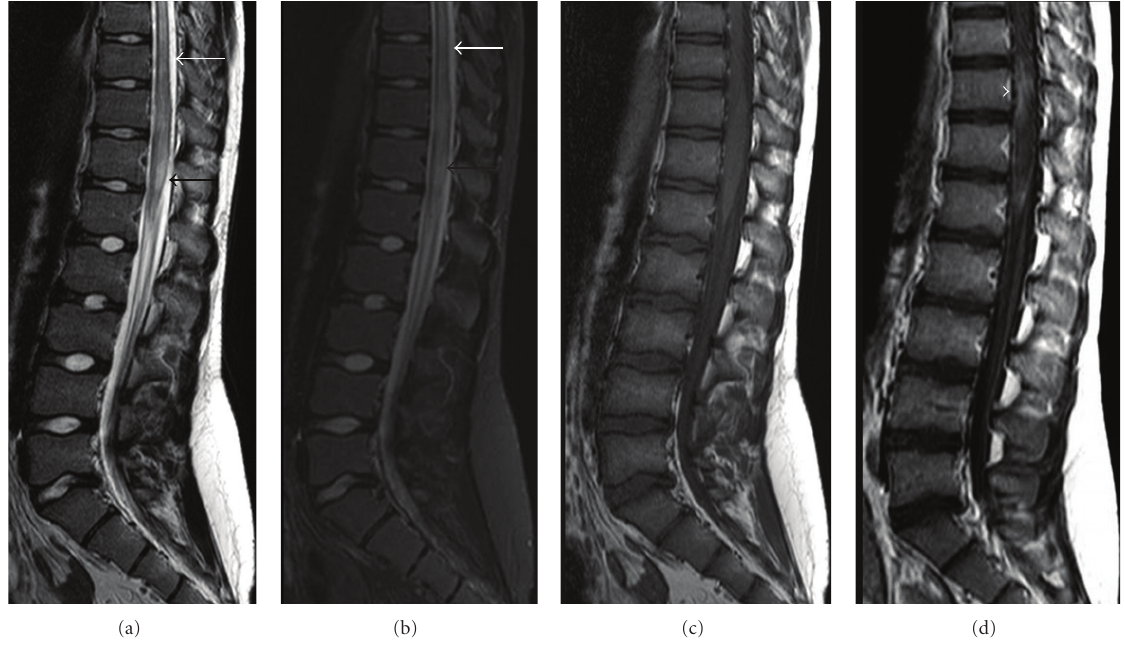
Figure 2: MR images of the dorsolumbar spinal cord. Sagittal T2WI (a) and STIR-T2WI (b) show patchy hyperintense lesions involving the distal lumbar spinal cord and the conus medullaris (black arrows). Mild spinal cord edema is also present (white arrows). Incidentally, posterior disc bulging is visualized at the level of L 5 -S 1 (black arrowhead). The lesions are isointense on T1WI (c). T1WI after intravenous gadolinium injection (d) demonstrates heterogeneous enhancement (white